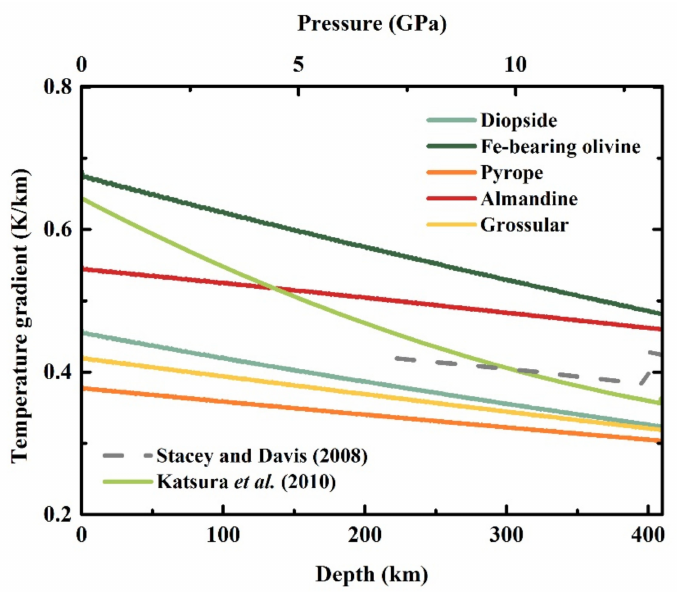
Figure 7. Adiabatic temperature gradients obtained using thermodynamic data on minerals ( T P = 1610